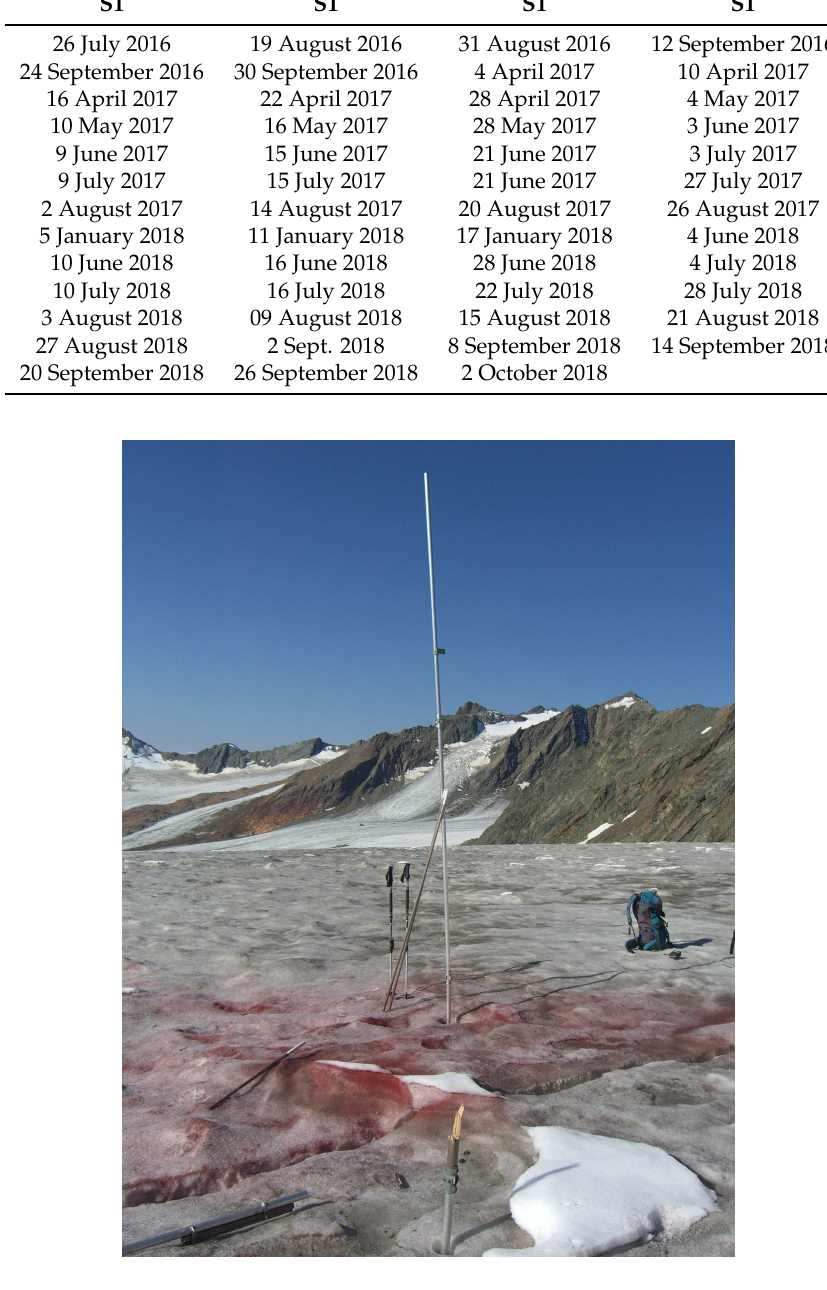
Figure A1. Picture of snow and perennial firn on Vernagtferner recorded in September 2018. The pole in the center is an accumulation stake, which used to be an ablation stake in summer 2018. See the backpack and ski poles for roughness height estimates. The red surface color has been spread out in previous years to detect the previous fall surface for winter field campaigns.